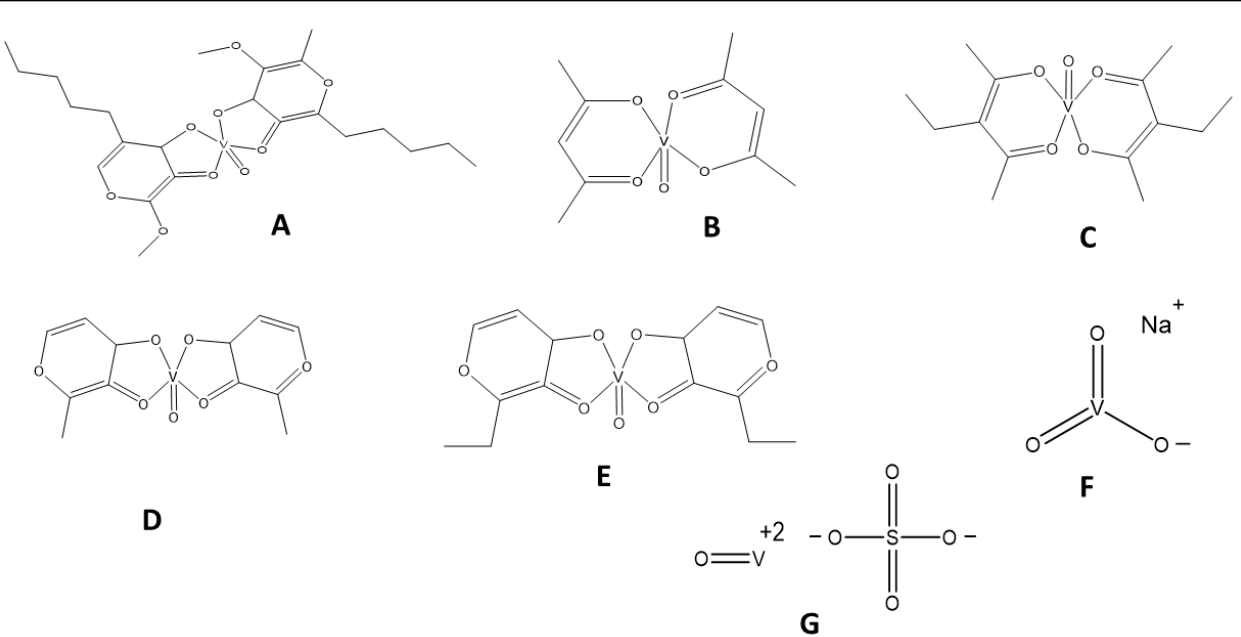
Figure 3. The structure of vanadium complexes with insulin-mimetic activity. ( A ) Bis(sallixinato) oxovanadium. ( B ) Vanadyl acetylacetonate. ( C ) Vanadyl 3-ethylacetylacetonate. ( D ) Bis(maltolato) oxovanadium. ( E ) Bis(2-ethyl-3-hydroxy-4-pyronato)oxovanadium(IV). ( F ) Sodium metavanadate. ( G ) Vanadyl sulfate.